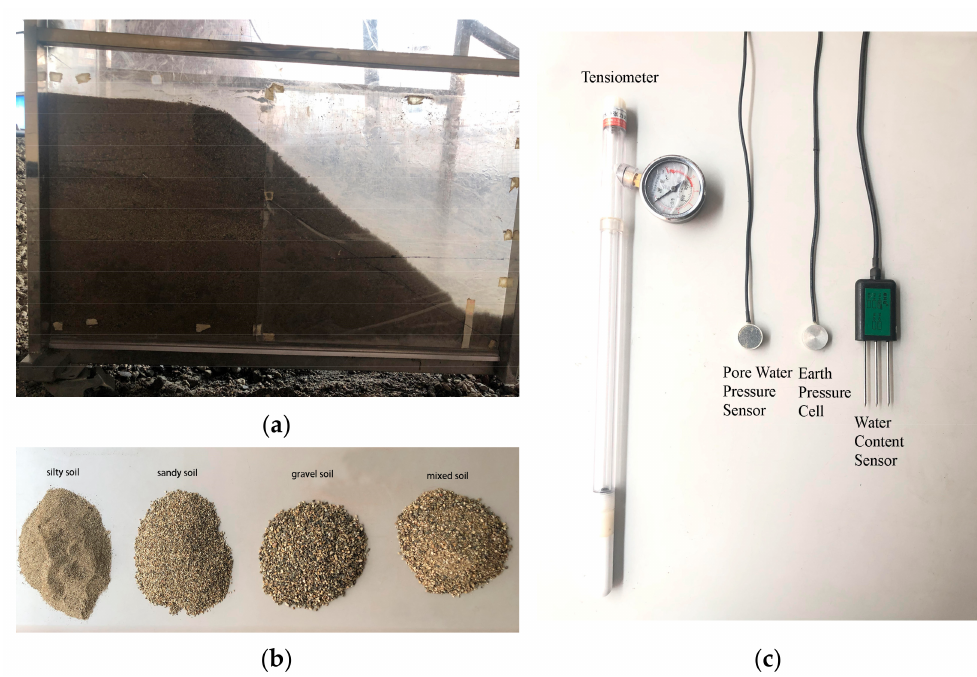
Figure 2. Tested samples and experimental apparatus: ( a ) side view of the slope; ( b ) soil samples; ( c ) measuring